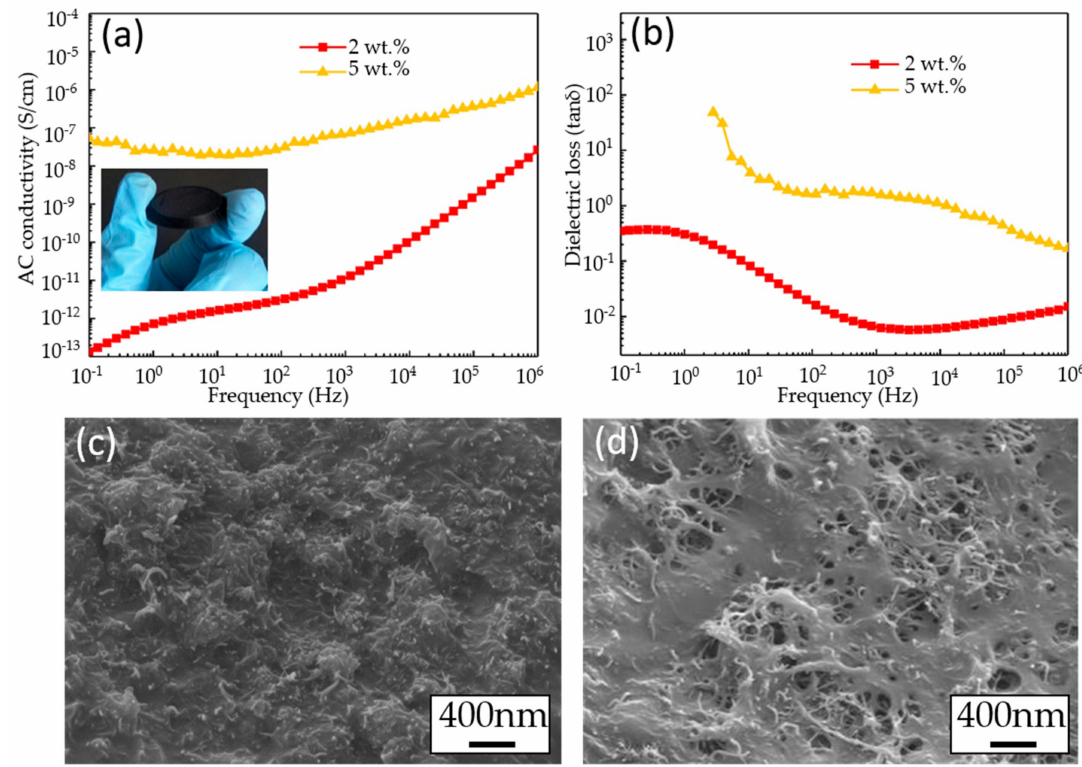
Figure 5. ( a ) The AC conductivity and ( b ) the dielectric loss (tan δ ) of PLA / MWCNT composites with the loading of 2 wt.% and 5 wt.%; The microstructure of PLA / MWCNT composites with the loadings: ( c ) 2 wt.%, ( d ) 5